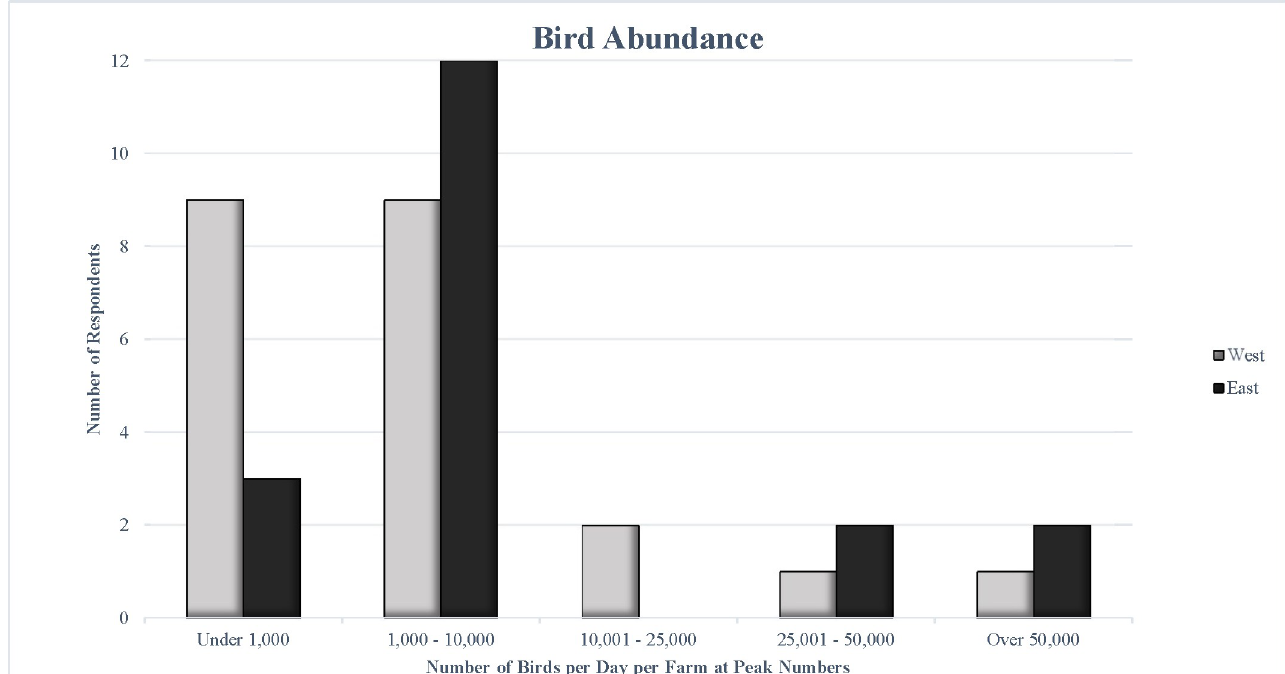
Fig 5. Number of birds present per day on each operation at peak numbers.